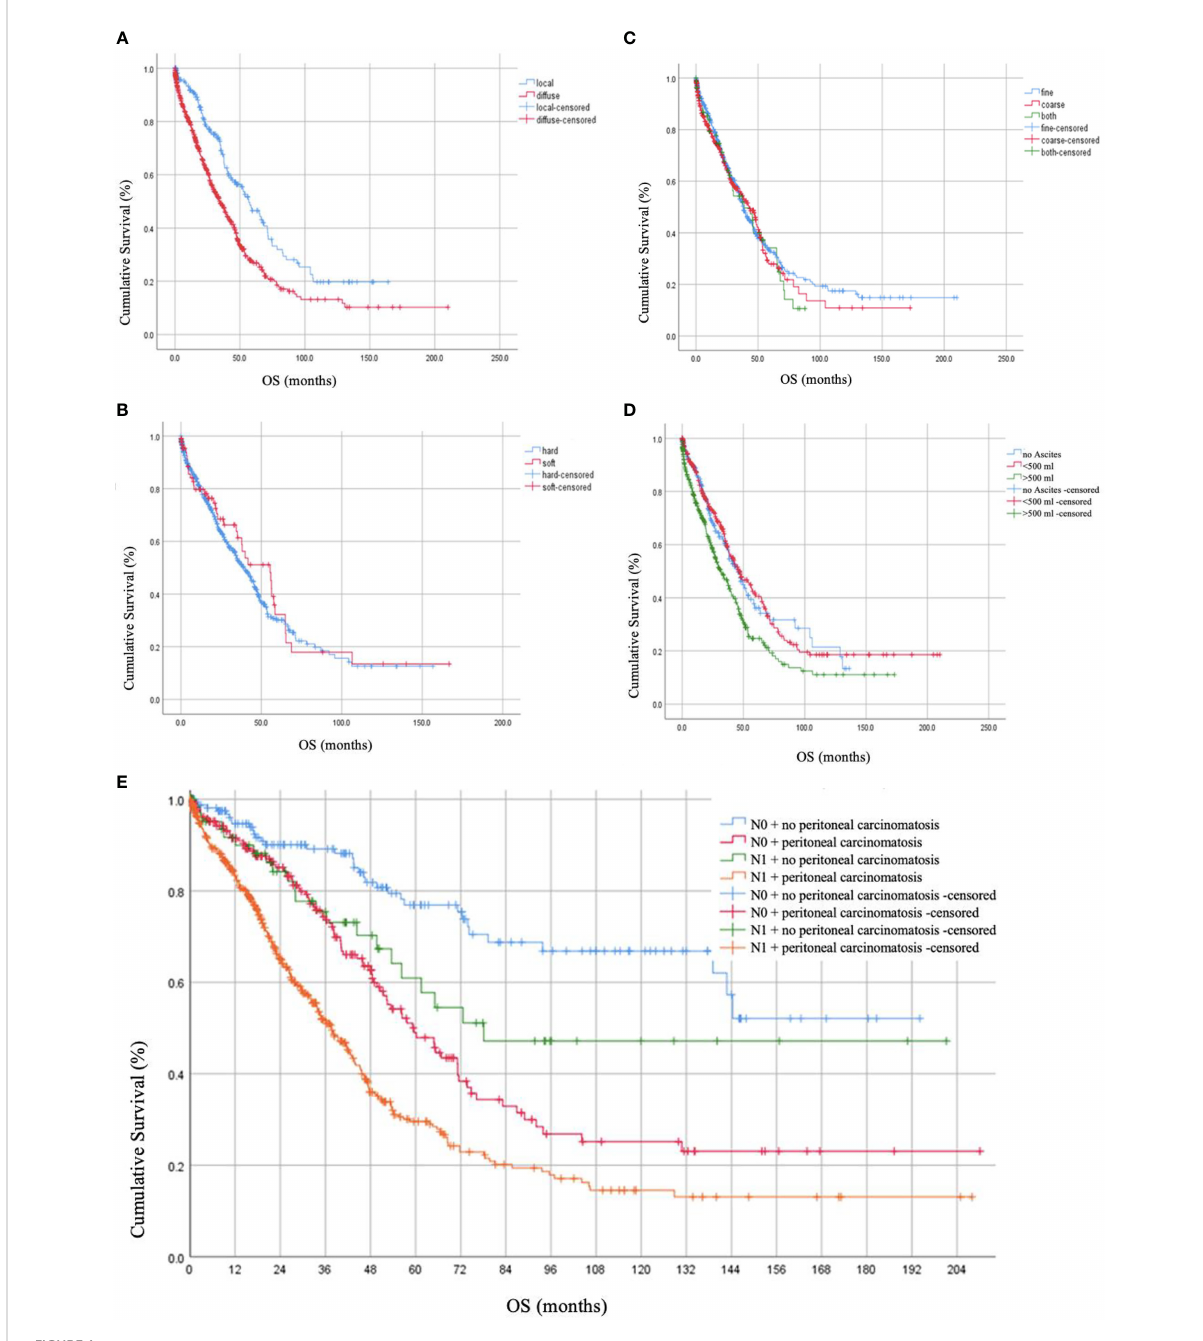
FIGURE 1 Overall Survival (OS) rates in months based on (A) localizationof peritoneal carcinomatosis, (B) consistencyof peritoneal carcinomatosis, (C) textureof peritoneal carcinomatosisnodules, (D) presenceof ascites together with peritoneal carcinomatosis, and (E) lymph node